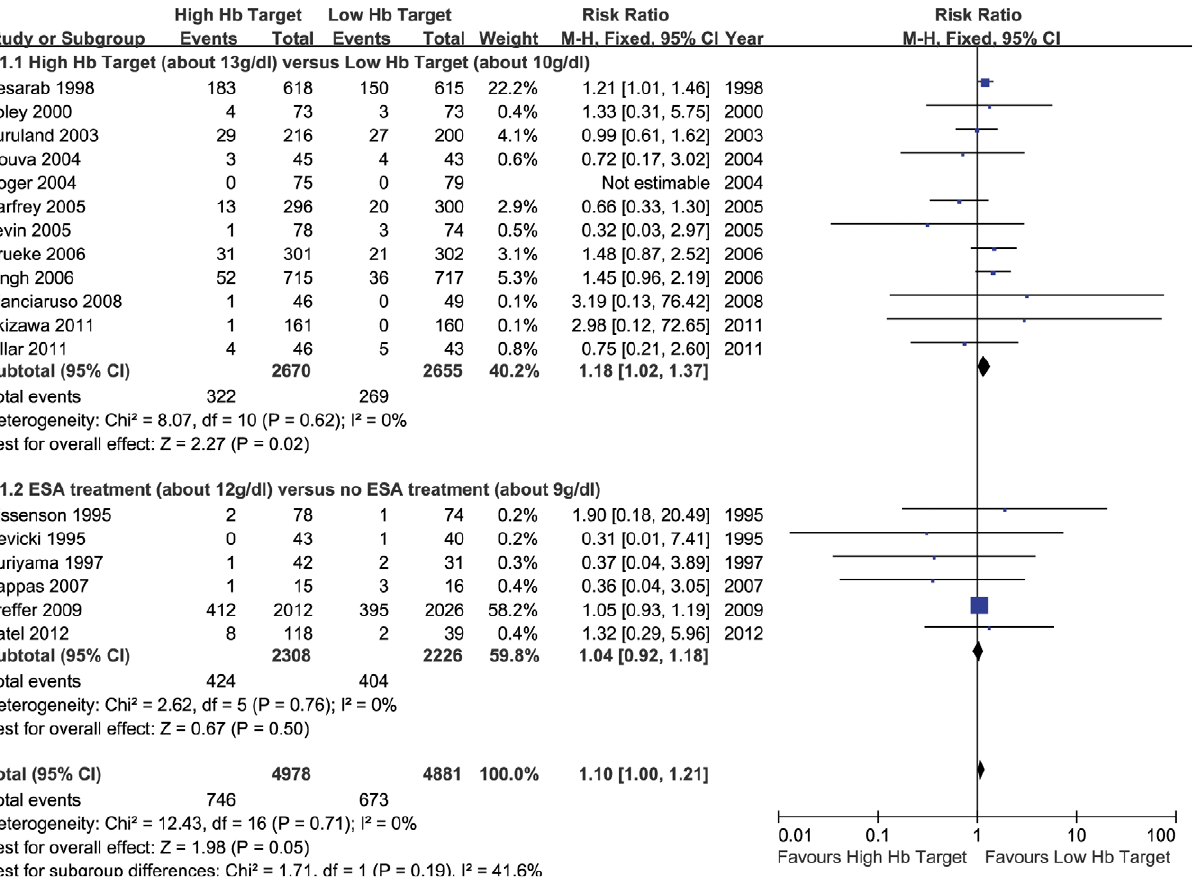
Figure 3. Meta-analysis of high Hb targets versus low Hb targets on mortality.